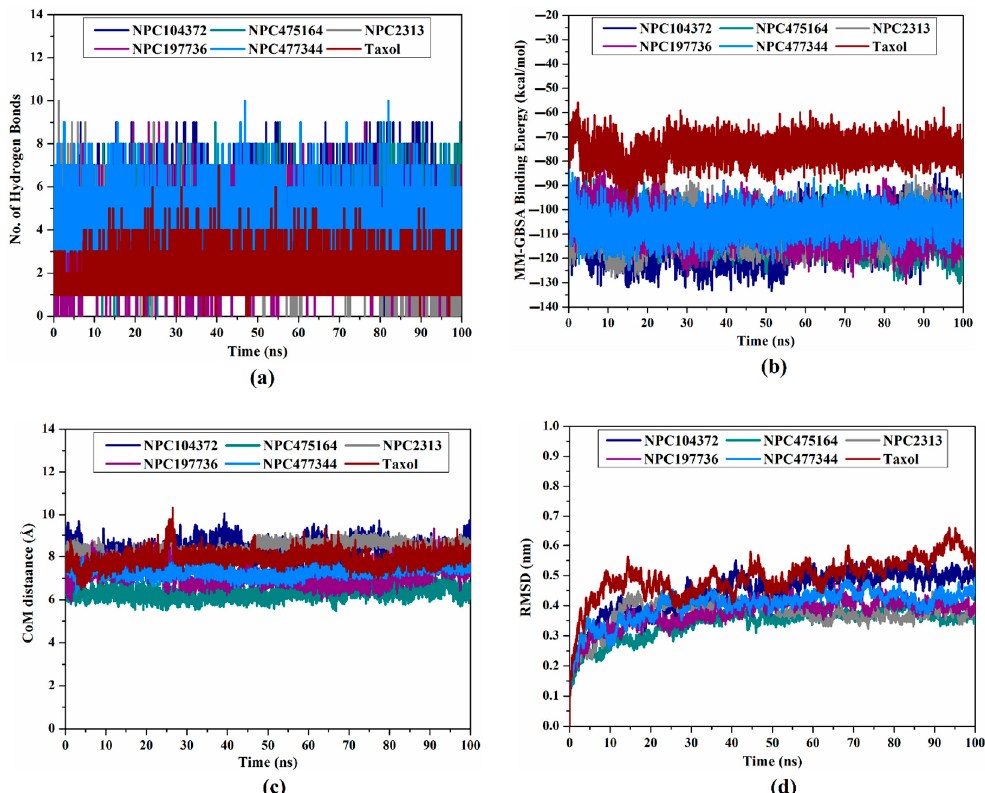
Figure 6. ( a ) The number of hydrogen bonds between the identified NPASS compounds and ABCB1 transporter, ( b ) evaluated MM-GBSA binding energy per frame, ( c ) center-of-mass (CoM) distances, and ( d ) root-mean-square deviation (RMSD) of the backbone atoms from the starting structure of NPC104372 (in navy), NPC475164 (in cyan), NPC2313 (in gray), NPC197736 (in light blue), and taxol (in wine) towards ABCB1 transporter throughout 100 ns MD simulations.